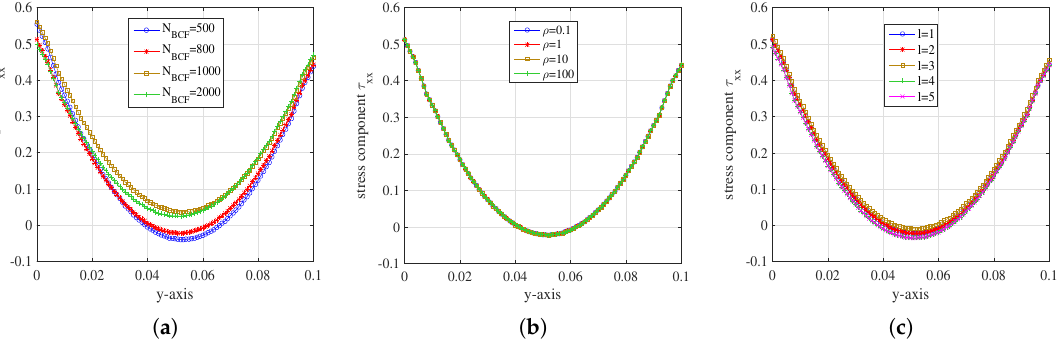
Figure 8. Stress component τ xx on the vertical channel wall during the steady state at t = 1.999185: ( a ) for different N BCF of Hooke model; ( b ) for different Re number of Hooke model; and ( c ) for different mesh levels of Hooke model.